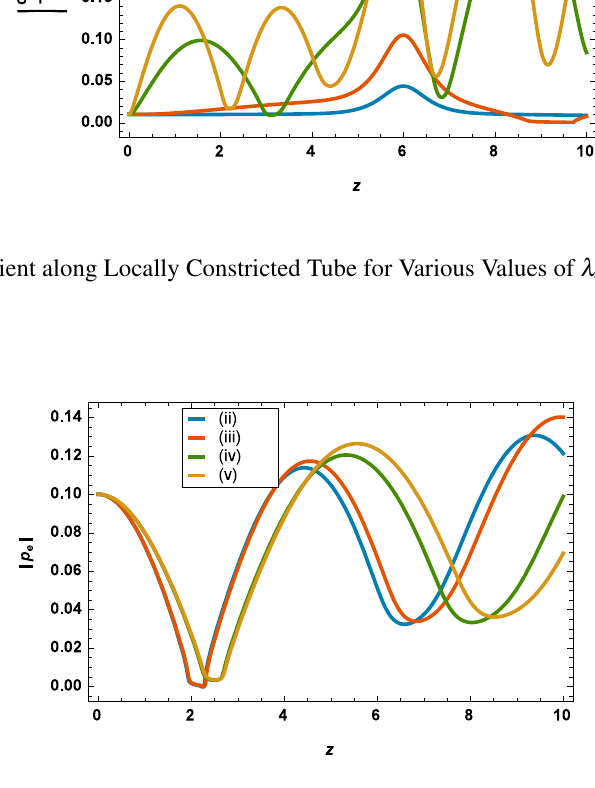
Fig. 7 Pressure along Tapered Tube for Various Pressure-Radius Relations with λ a = 0 . 75 , α = 15 , β = 0 .